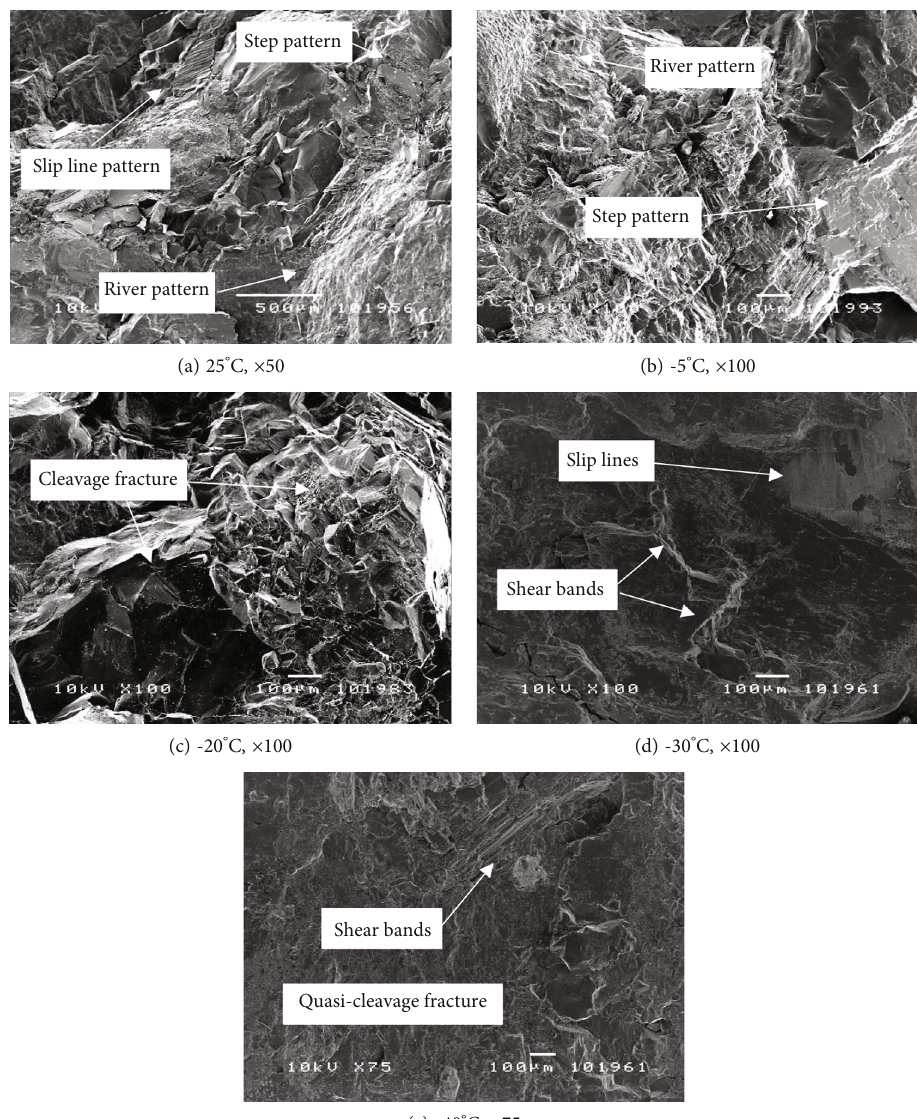
Figure 11: Fracture morphology of granite in di ff erent